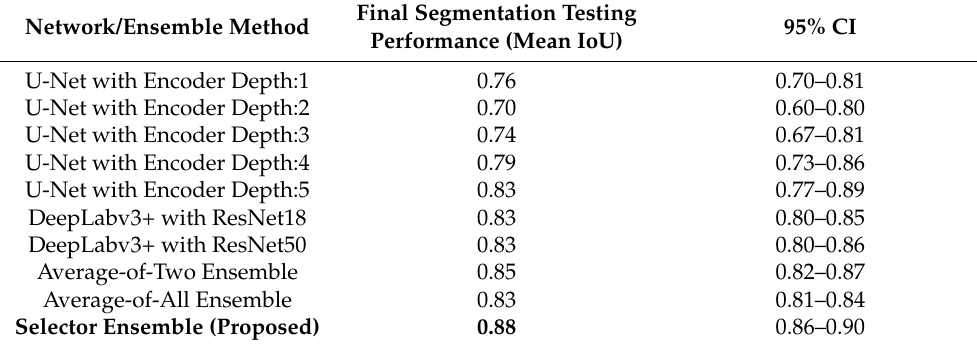
Table 7. Averaged mean IoU values of the final lung segmentations obtained during testing with the ‘selected’ cases out of 140 CRs from the JSRT dataset. The highest performance value is marked in